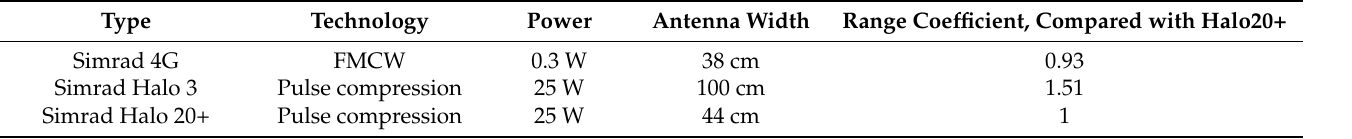
Table 1. Comparison of the radars’